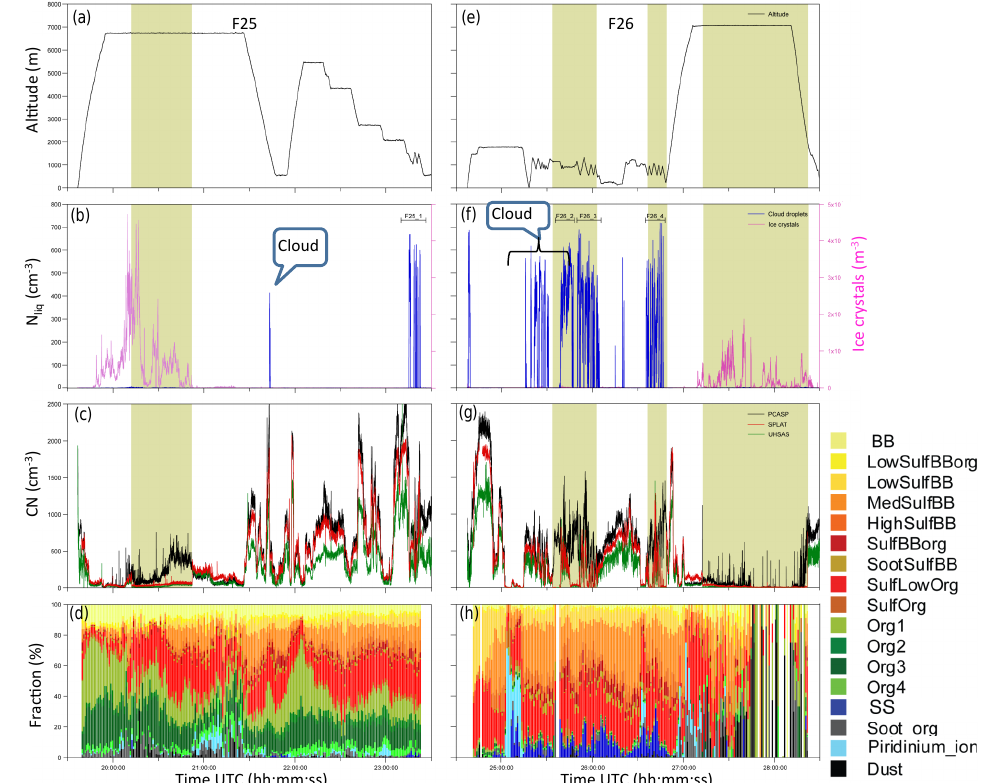
Figure 2. ISDAC 2008 aerosol and flight characteristics near and in selected clouds influenced by biomass burning from 19 April (left) and 20 April (right). Flight characteristics shown include: (a) altitude, (b) LWC (blue) and IWC (pink), (c) aerosol concentration from the PCASP (black), SPLAT (red), and UHSAS (green) instruments, and (d) bulk aerosol SPLAT chemical composition. Tan shading indicates SPLAT sampling through the in-cloud CVI inlet.